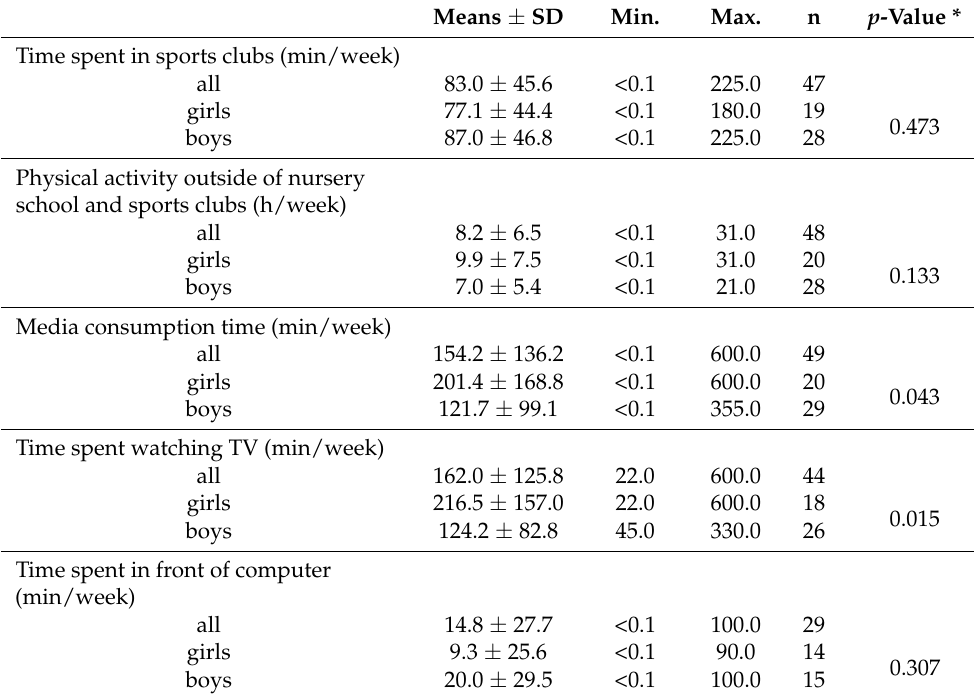
Table 4. Means of leisure time behaviour overall and separated by gender.